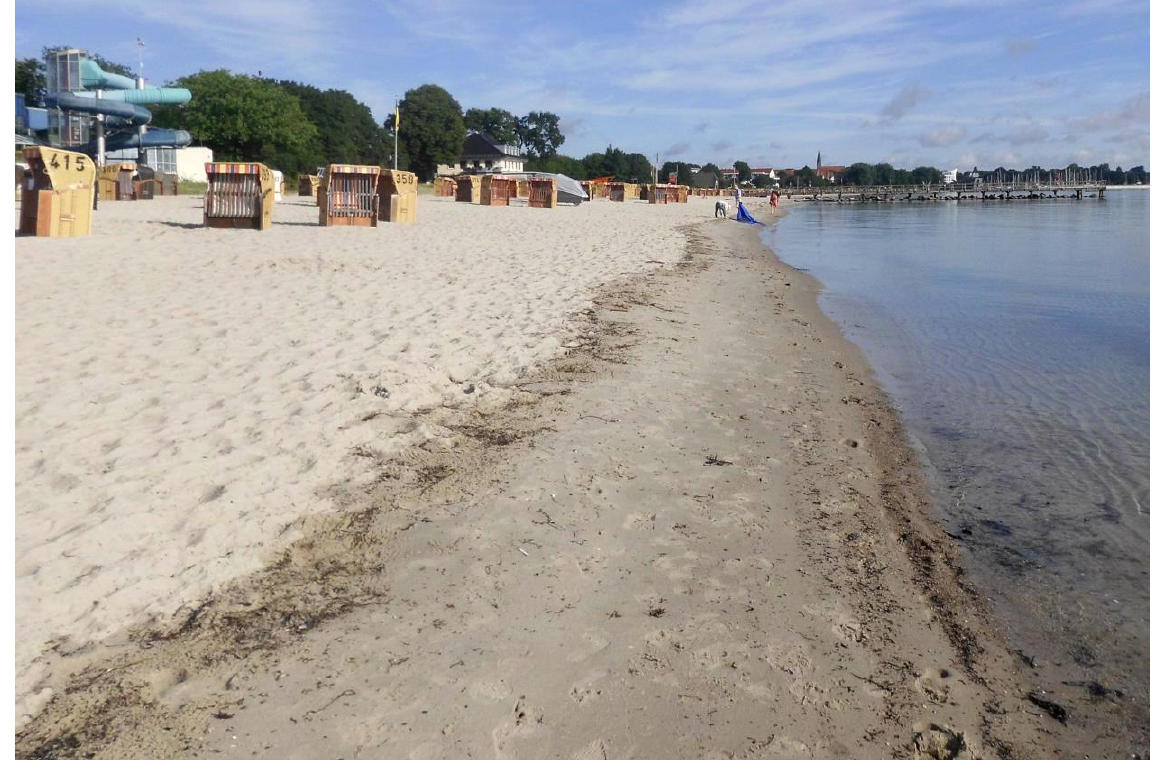
Figure S2: Density of beach wrack (333 g m -1 eelgrass + 200 g m -1 Ceramium ) tested for effects on beach visitors in field experiment